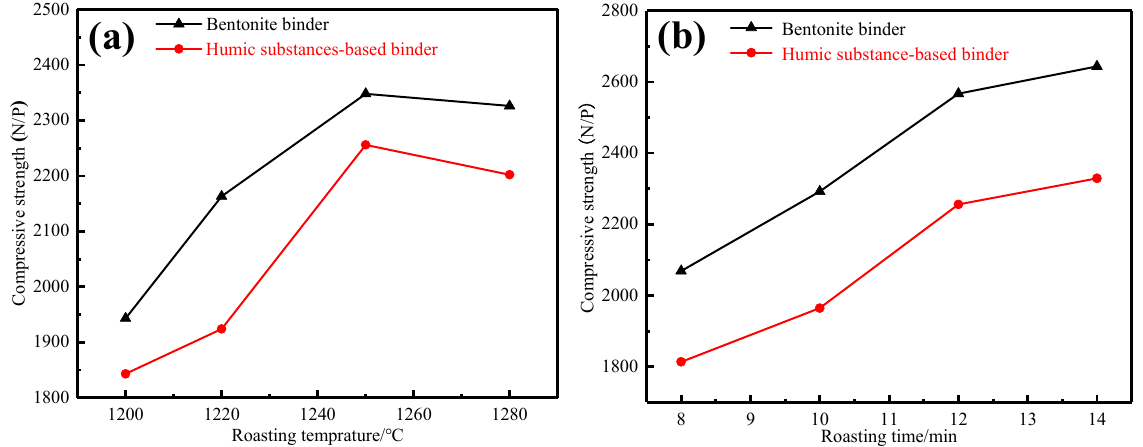
Figure 8. Effects of roasting parameters on the compressive strengths of roasted pellets; ( a ) roasting time 12 min; ( b ) roasting temperature 1250 °C.